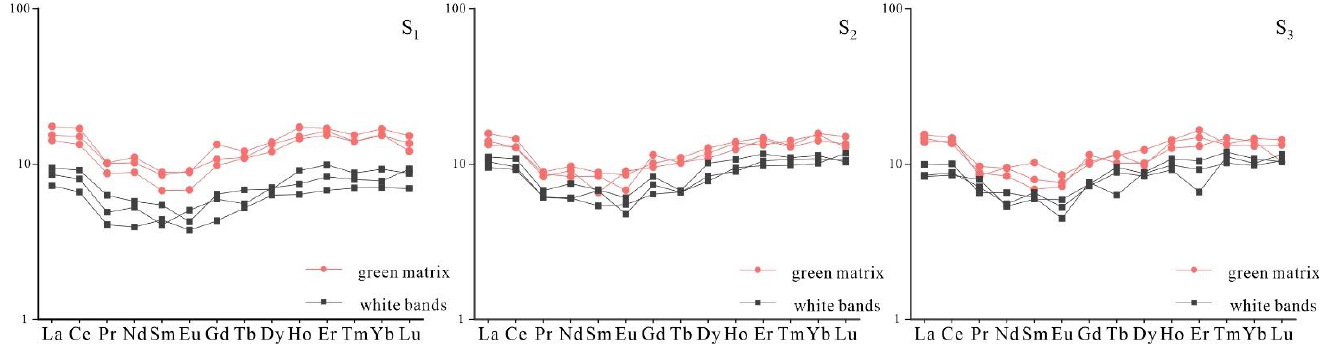
Figure 7. Chondrite-normalized REE patterns of three cabochon specimens of Lvwen stone. Table 4. REE characteristics of three Lvwen stone specimens (all values in ppm).